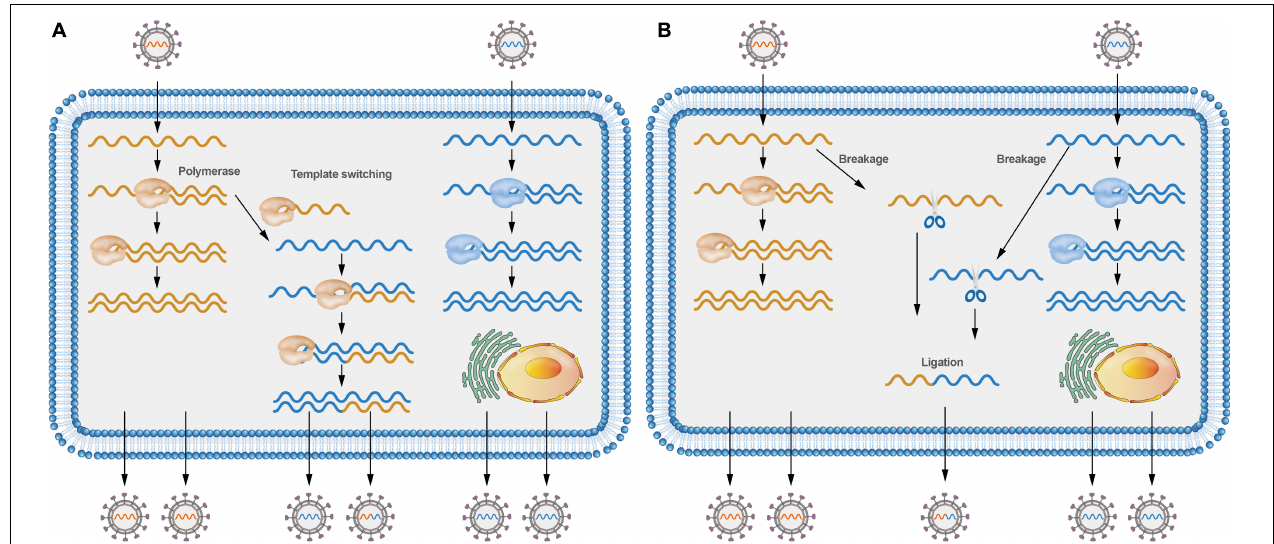
FIGURE 2 | Models of positive-sense RNA viruses’ recombination. (A) Different viruses co-infecting a cell can switch viral templates, and RdRP can switch from donor template to receptor template to generate recombinant molecules. (B) Different viruses co-infecting a cell can lead to virus RNA breakage; RNA molecules can be cut at specific sites and then joined to form recombinant